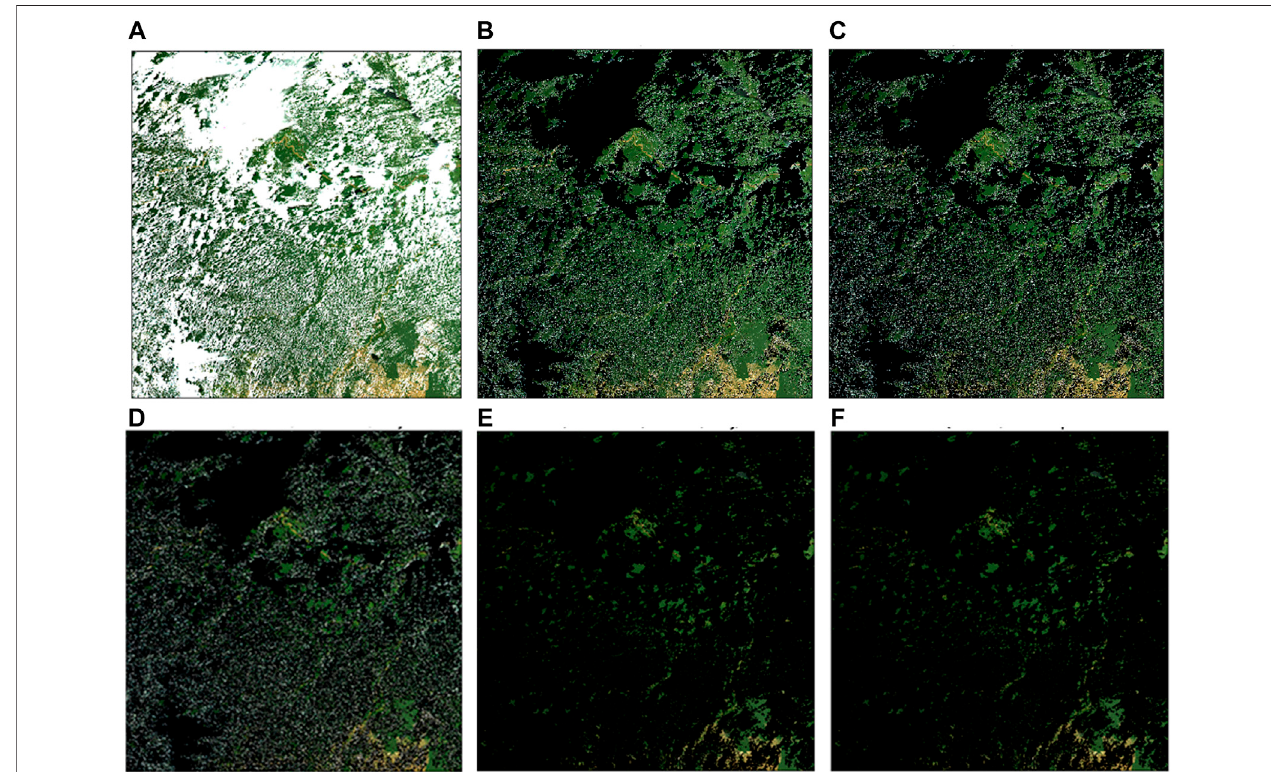
FIGURE2| Illustration ofQA fi lteringfortileH11V09 acquired inDOY 200,2018: (A) TOARGBMODIS image; (B – F) RGBMYD09 SRafter incremental application ofQA fi lters: (B) “ Cloud state ” and “ cirrus detected ” and “ internalcloud algorithm ” fl ags; (C) added “ cloud shadow ” ; (D) added “ adjacency tocloud ” ; (E) added “ aerosol quantity ” ; (F) added “ MODLANDQAbits ” and “ band1dataquality ” and “ band2dataquality ” and “ Atm.Corr.performed ” .Theblackcolorinimages (B – F) shows fi ltered pixels ( fi ll values).